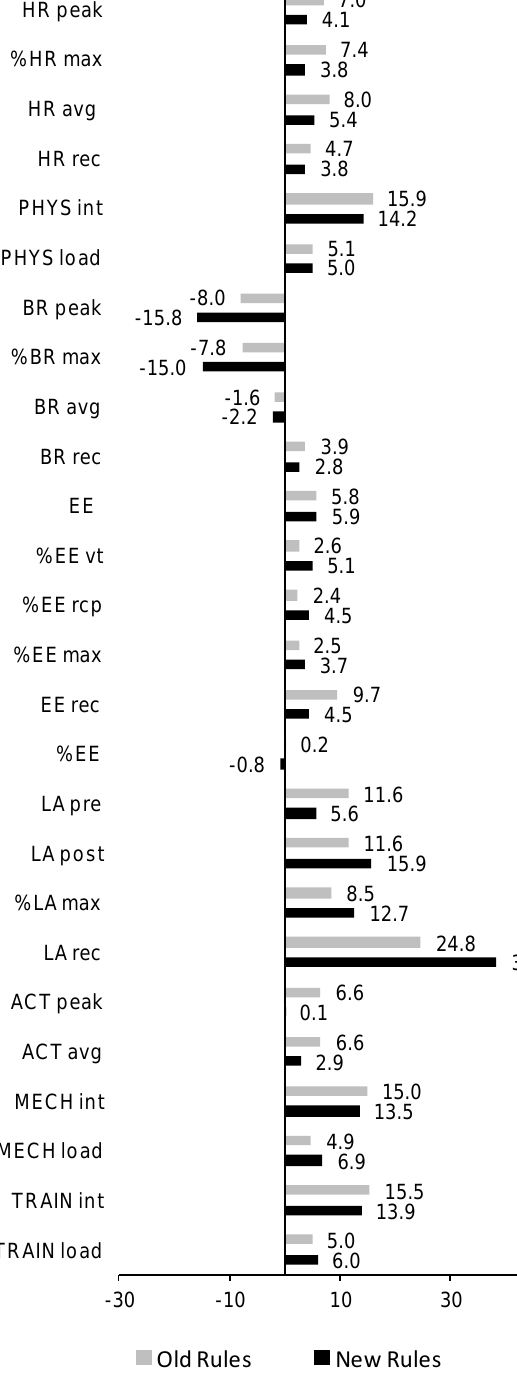
Figure 3. Percentage differences in exercise response between taekwondo-specific circuit sessions and real combat. Old rules are displayed as gray bars and new rules as black bars. Positive numbers indicate higher values obtained during combat vs. training sessions. See table legends for the explanation of variable abbreviations.